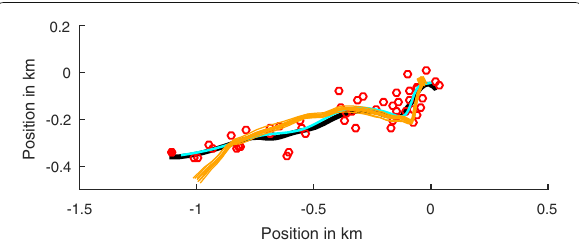
Fig. 9 The ensemble of Fig. 7 after updating with all measurements in the order y 1 , ... y L . The RTS solution is covered well